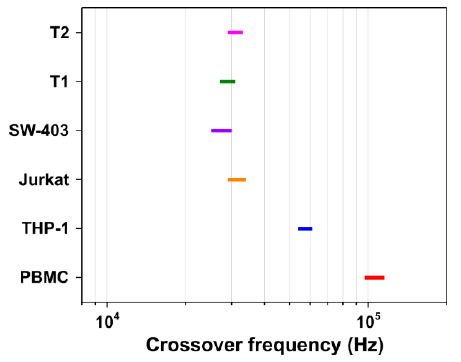
Figure 4. The DEP crossover frequency for the different types of cancer cells and healthy peripheral blood mononuclear cells.